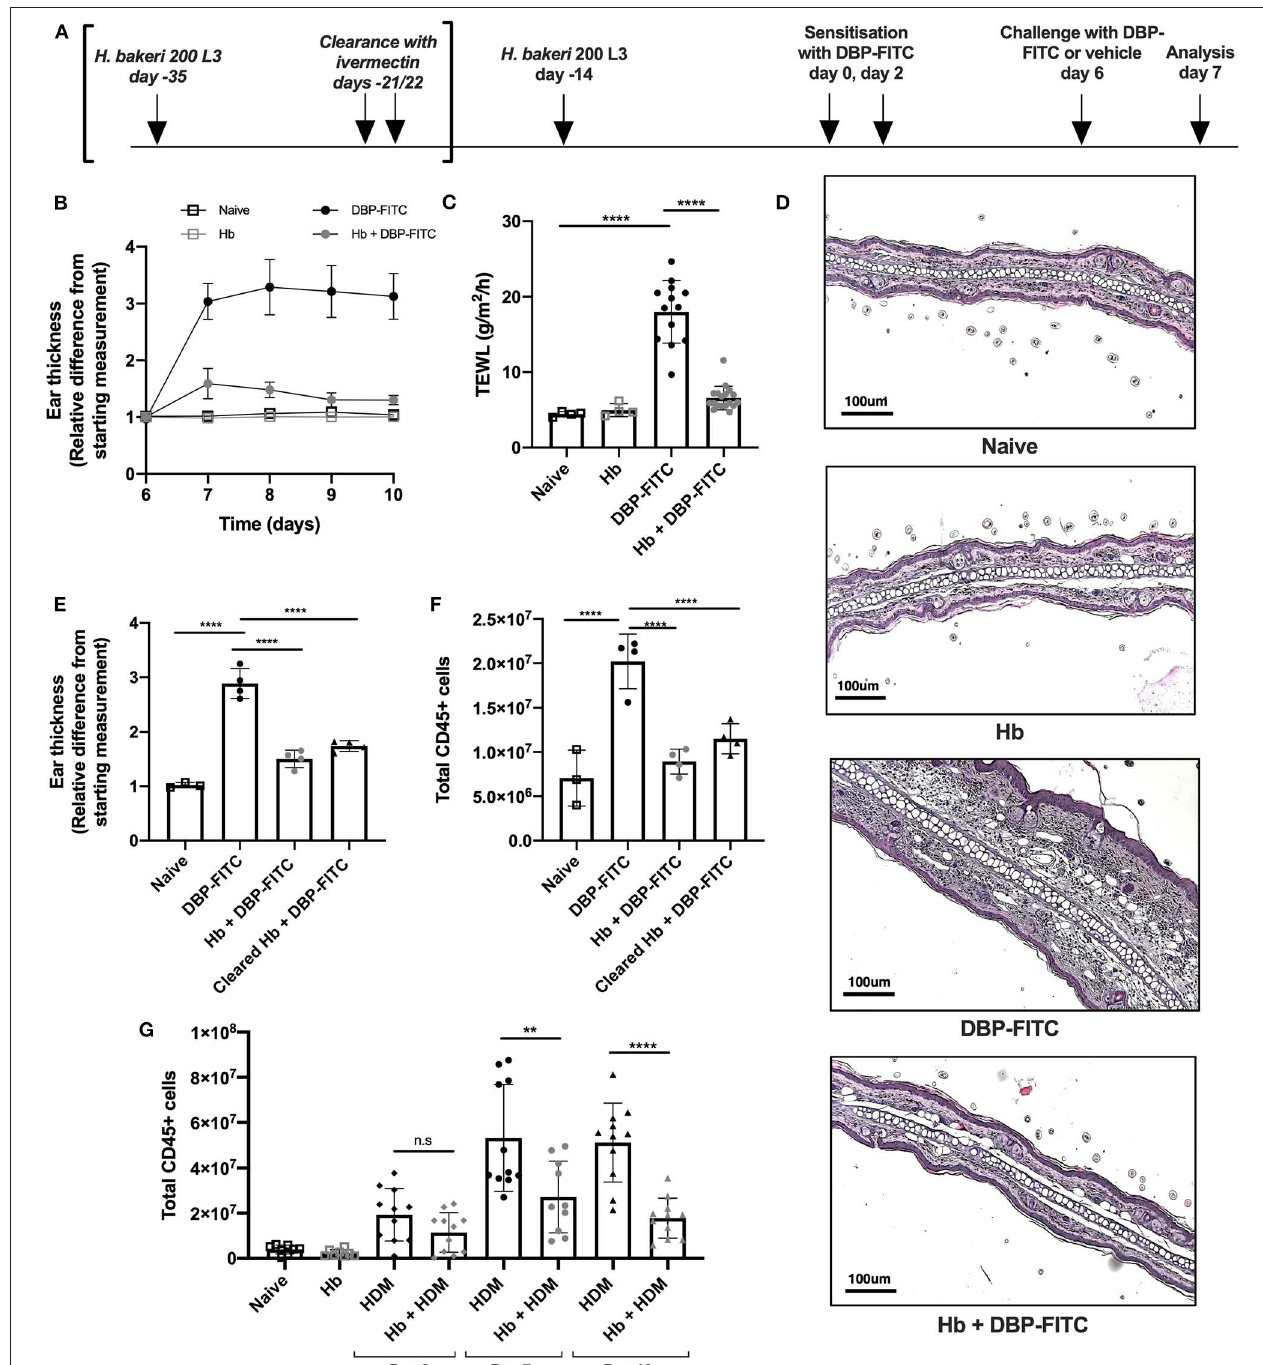
FIGURE 1 | DBP-FITC-induced skin inflammation is suppressed by H. bakeri infection. (A) Timeline of Hb infection and DBP-FITC topical sensitization and challenge model. lvermectin treatment for Hb clearance experiments [results in (E,F) ] is shown in brackets. (B) Relative difference in ear thickness compared to day 6 baseline measurements, in naïve mice (black lined clear squares), Hb -infected mice (gray lined clear squares) or in mice challenged DBP-FITC (gray circles) or without (black circles) prior Hb infection. (C) TEWL (g/m2/h) at site of DBP-FITC challenge measured at day 7, or in control naive mice. (D) Ear sections stained with H&E on day 7. Scale bars represent 100 um. (E) Relative difference in ear thickness in naïve mice, or at day 7 after DBP-FITC challenge in mice with Hb infection, or after clearance of the infection. (F) Total number of live CD45 + cells in ear dLN at day 7 in the same groups as (E) . (G) Total number of live CD45 + cells in ear dLN at days 3, 7, and 10 post-HDM intradermal injection into the ear, with or without prior Hb infection, or in naive mice. A one-way ANOVA with Tuckey’s multiple comparisons test was used to test statistical significance. Graphs represent data combined from 2 experiments (B,C,G) or are representative of 2 repeat experiments (D,E,F) and show mean ± SD. n.s, not significant; ** p < 0.01, **** p < 0.0001.